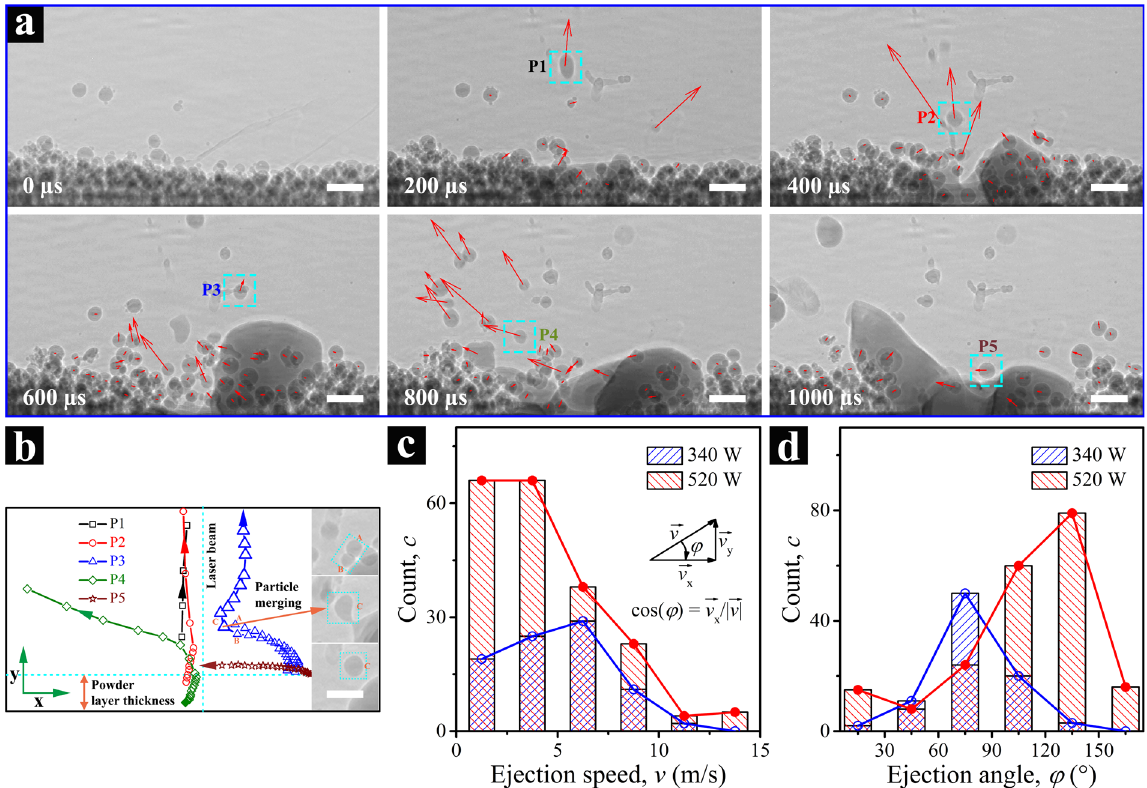
Figure 4. Tracking of powder motion during the laser powder bed fusion process of Ti-6Al-4V. ( a ) Dynamic X-ray images collected at different times, with red arrows indicating the velocity of each individual powder particle. In this case, the laser power and beam size are 520 W and ~220 µ m (1/e 2 ), respectively. The particle size is in the range of 5–45 µ m, and the powder layer thickness is ~100 µ m. The full tracking procedure for two laser power conditions are shown in Supplementary Videos 5 and 6. ( b ) Moving trajectories of five different particles P1–P5, which are marked out using cyan dashed squares in ( a ). The dimensions of ( b ) and each image in ( a ) are identical. The vertical and horizontal cyan dashed lines specify the location of the laser beam and the top surface of the powder bed, respectively. The insets of ( b ) show a particle merging process. All the scale bars in ( a ) and ( b ) are 100 µ m. ( c , d ) Statistics of the powder moving velocity. Distributions of ( c ) ejection speed and ( d ) ejection angle of particles outside the powder bed under the laser power of 340 W and 520 W are shown in blue and red colors,